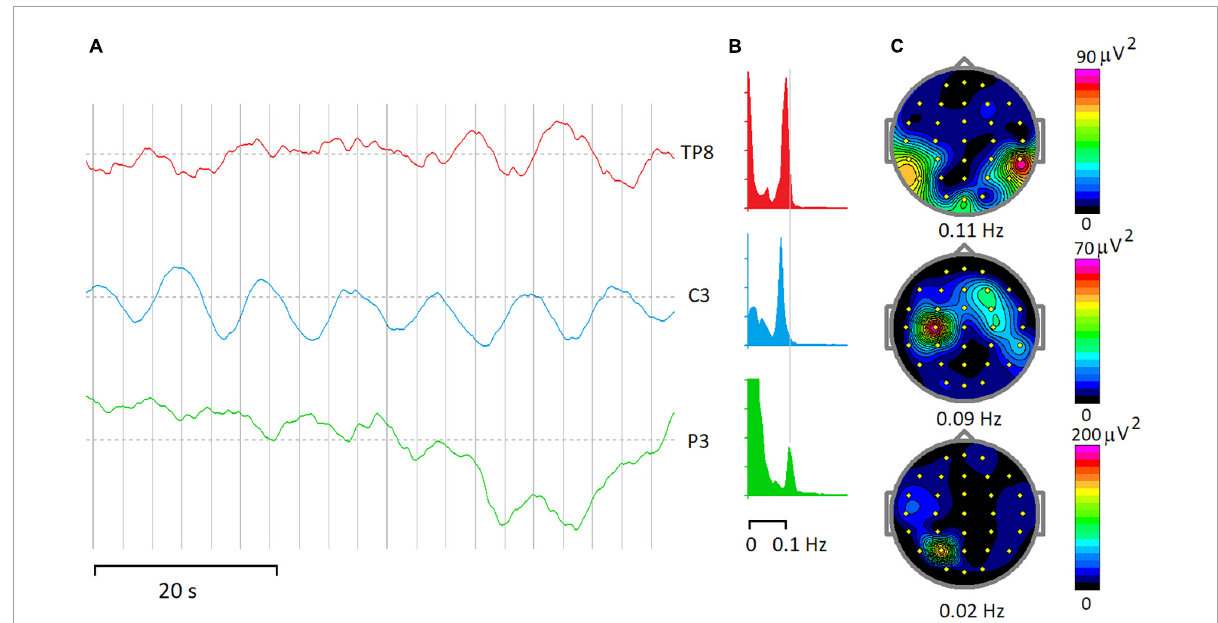
FIGURE2 Rhythmic and arrhythmic EEG-ISF. (A) Fragments of EEG-ISF in a subject during a continuous performing task. (B) Power spectra of 20-min of the EEG record. (C) Maps of EEG spectra at the frequencies depicted below. Note that peaks at 0.09–0.11 Hz dominate spectra at TP8 and C3 electrodes, while a power spectrum below 0.1 Hz shows the highest magnitude for the P3